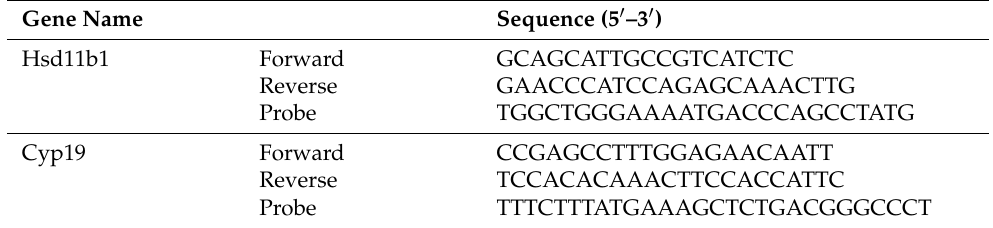
Table 2. Sequences of primers and probes synthesized for real-time qPCR assays.